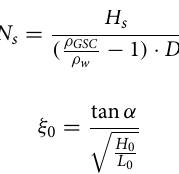
where N s is the stability number and ξ 0 is the surf similarity parameter and is represented by (4) and (5). H s is the incident significant wave height, ρ w and ρ GSC correspond to the density of seawater and GSC. D is the thickness of armour layer given by l.sinα, where l is the length of GSC armour units, α is the slope angle of the geosynthetic structure, L 0 is the deepwater wavelength, equals to gT 2 /2π, where T is the wave period.